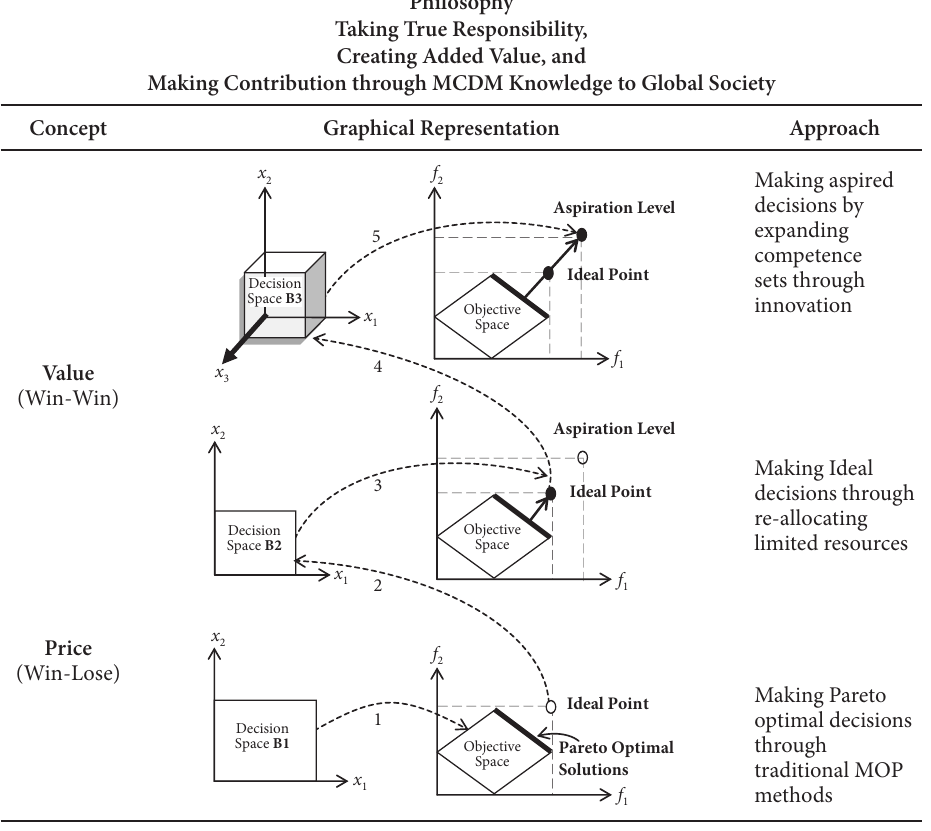
Fig. A3. Extension of changeable decision space and aspiration